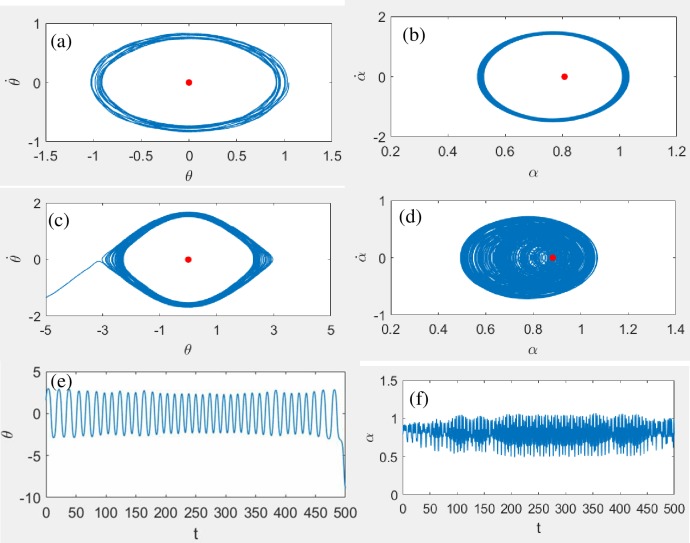
The dynamic simulations with the parameters in the periodic or chaotic state under randomly uncertain disturbances with the amplitude A1 = 0.1 and A2 = 0.1.(a) and (b): phase diagram with the parameters in the periodic state; (c)–(f): dynamic responses with the parameters in the chaotic state. The red dot indicates the equilibrium point.